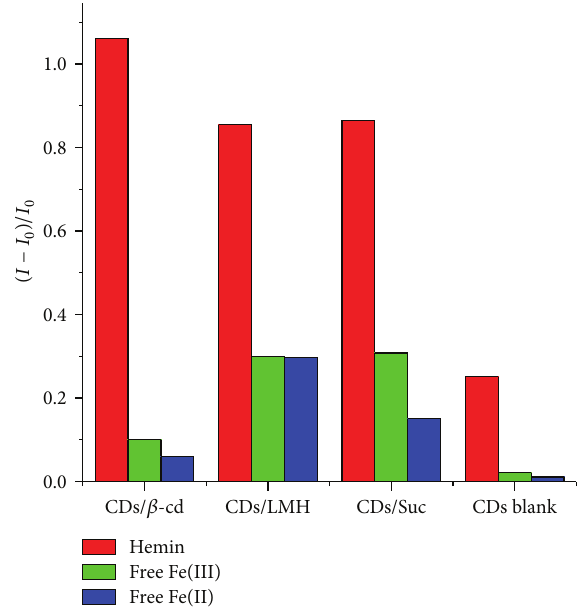
Figure 5: Comparative plot of change in PL intensity of carbon dots and carbon dot capped systems with regard to hemin, free Fe(II), and free